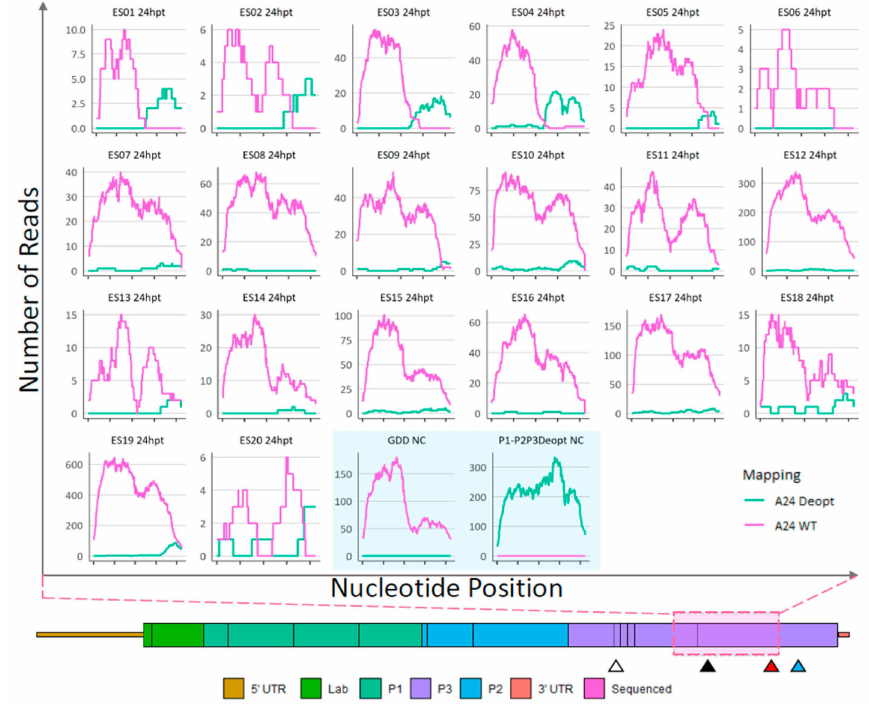
Figure 5. Sequence analysis of 24-hpt ∆ P1-P2P3Deopt × ∆ GDD recombinant plaque isolates and ∆ P1-P2P3Deopt or ∆ GDD transfection total cell supernatant (shaded blue box). Locations ( x -axis) and counts ( y -axis) of reads that preferentially map to either a A24-WT or A24-P2P3Deopt reference within a 1059 nt section of the 3CD coding region as indicated by the pink shaded box. Triangles indicate the location of the 3B DIVA marker (white), 3D DIVA marker (black), the boundary between deoptimized and non-deoptimized regions (red), and the GDD deletion